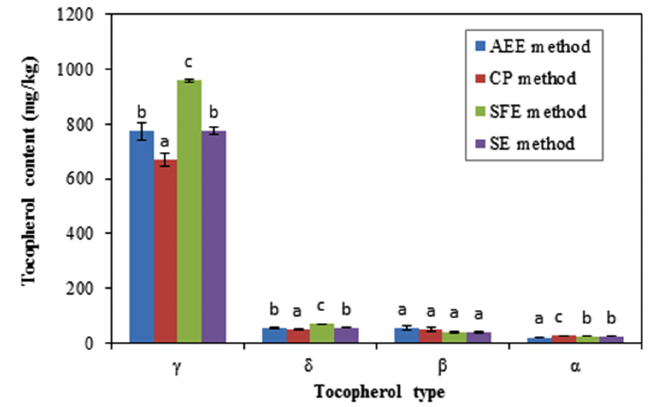
Fig. 2: Individual tocopherol contents of APO samples extracted by diffe- rent methods [results with standard deviations shown by same letters (a-c) are not significantly different (p < 0.05)]